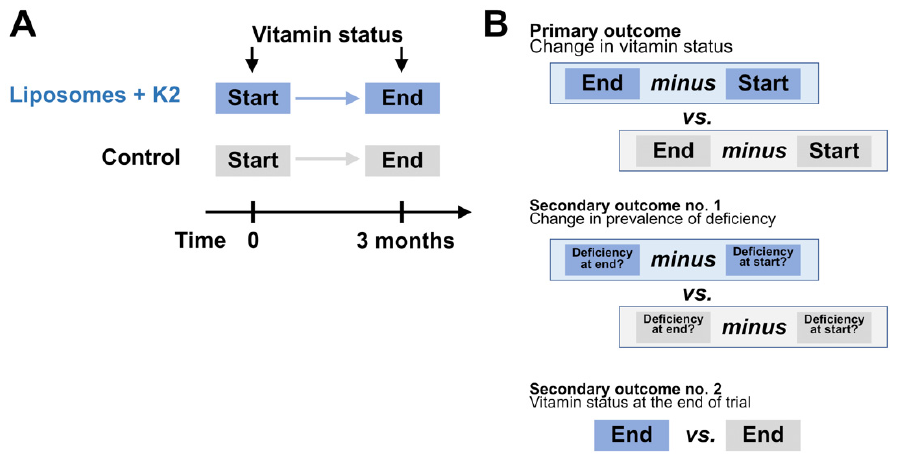
serum: vitamin A (all-trans-retinol), vitamin D3 (25-hydroxyvitamin D), vitamin E